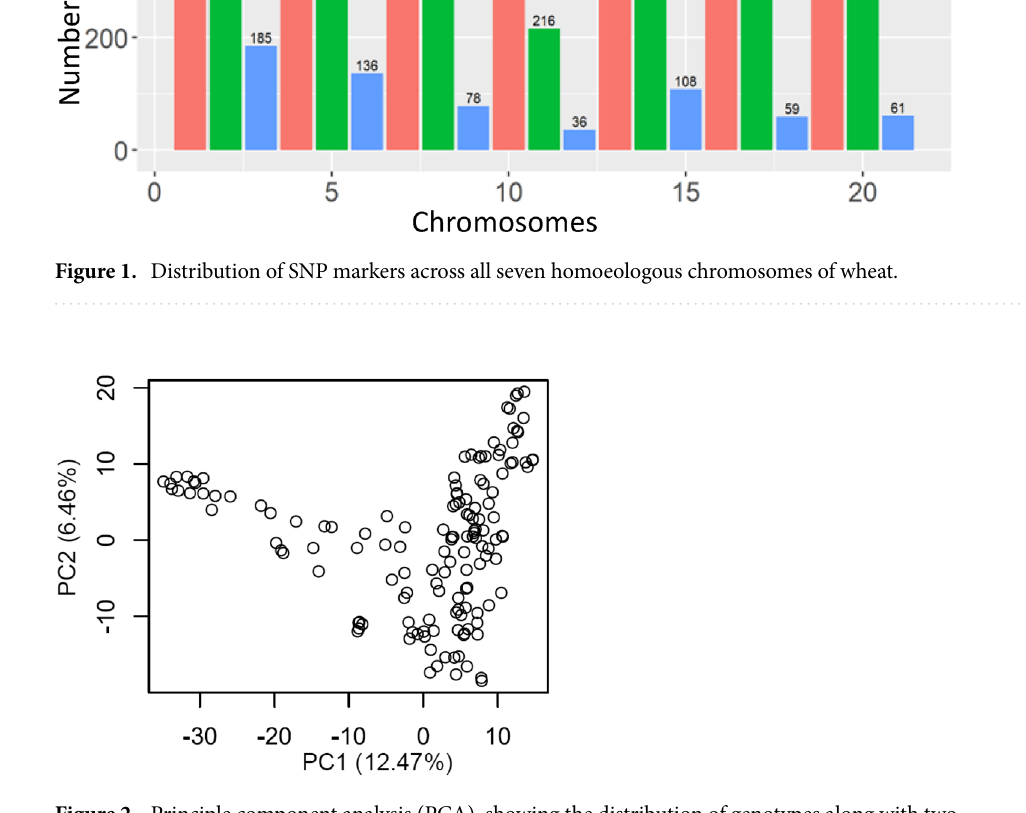
ers, after filtering SNP markers with a missing rate higher than 10%, minor allele frequency (MAF) lower than 5% and heterozygosity higher than 10%. Marker coverage of the SNPs over the chromosomes is shown in Fig. 1.